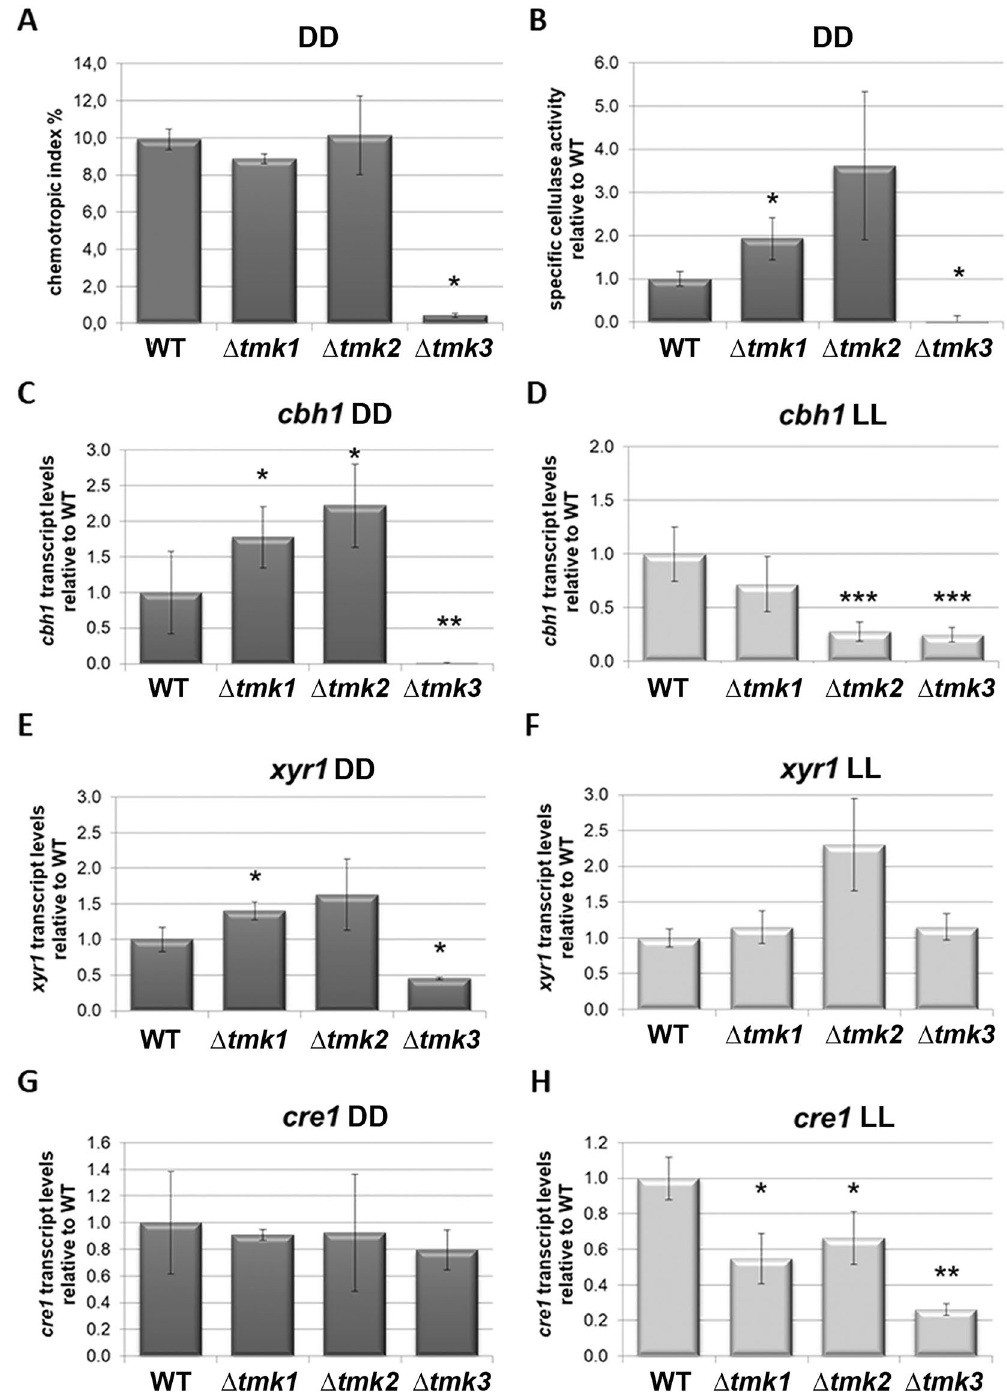
Figure 2. Relevance of MAPkinases for chemotropic response and cellulase regulation. ( A ) Chemotropic response of MAPkinase mutant strains to 1% glucose. ( B ) Specific cellulase activity upon growth on 1% cellulose in darkness. ( C , D ) Transcript levels of cbh1 upon growth on 1% cellulose ( C ) in constant darkness and ( D ) constant light. ( E , F ) Transcript levels of xyr1 upon growth on 1% cellulose ( E ) in constant darkness and ( F ) constant light. ( G , H ) Transcript levels of cre1 upon growth on 1% cellulose ( G ) in constant darkness and ( H ) constant